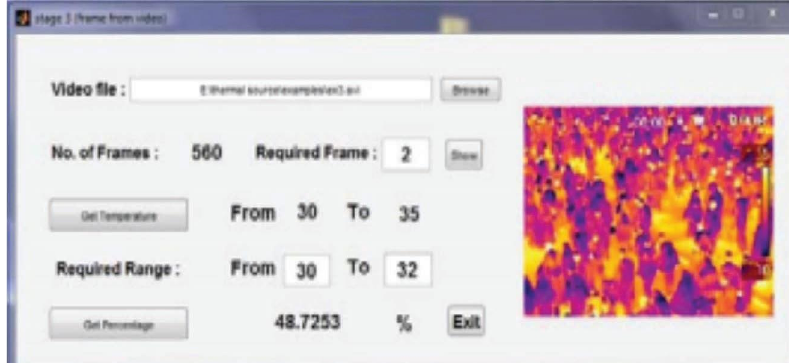
Figure 18: Density calculation using a thermal image utilizing heat signature by CMINS [13].